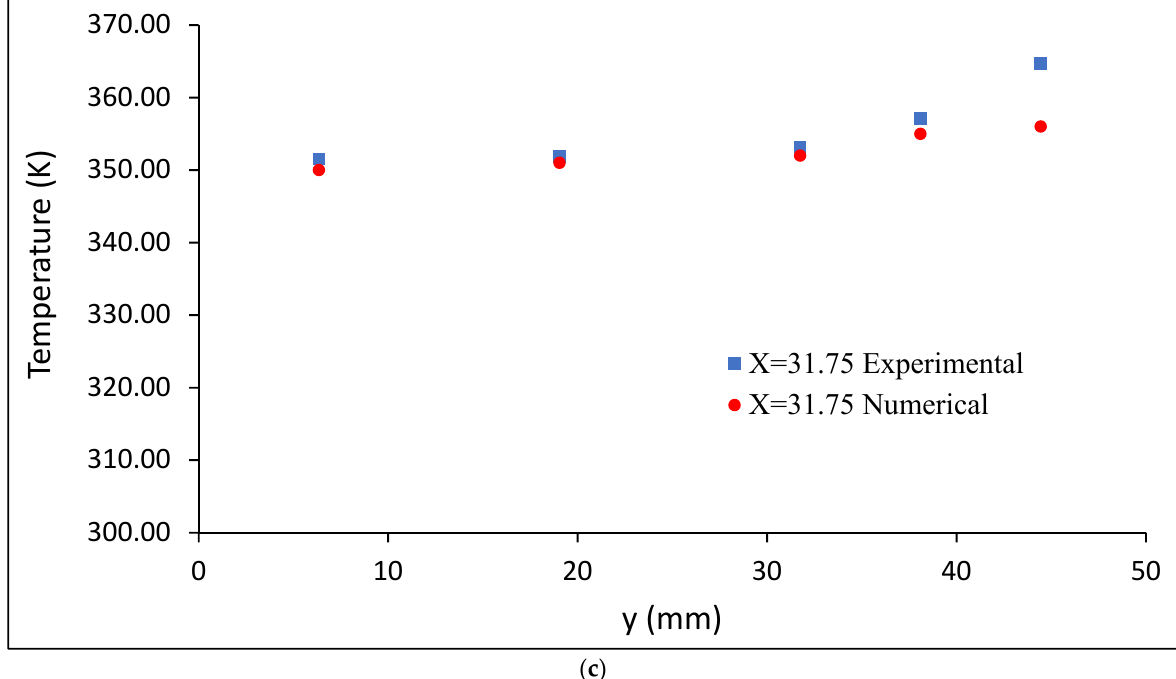
Figure 9. Comparison between EPS models’ prediction and the experimental data of [67] at an average air speed of 2.50 m/s and at the axial location form the inlet: ( a ) 6.35 cm, ( b ) 19.05 cm, ( c ) 31.75 cm. Table 3. Percentage error between the EPS models’ predicted and experimental temperatures at an air speed of 2.50 m/s.